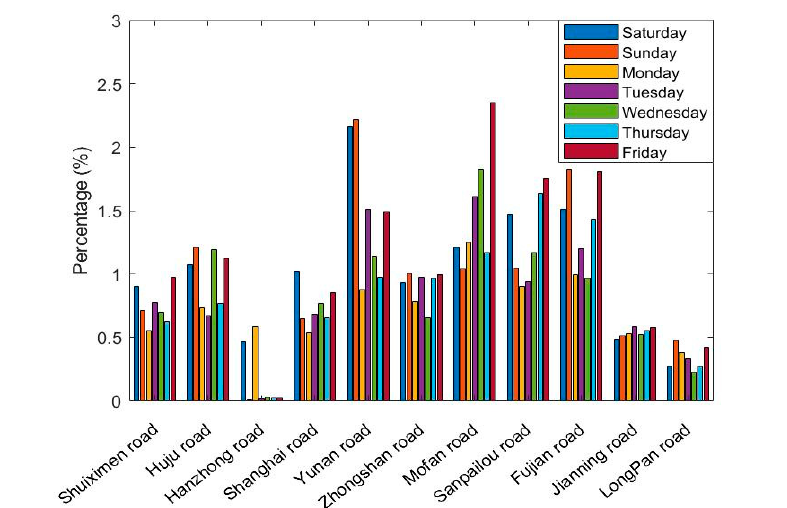
Figure 6. Percentage of speeding and severe accelerations for the whole data instances, for the Bus No. xxx line on 11 roads in 7 days.